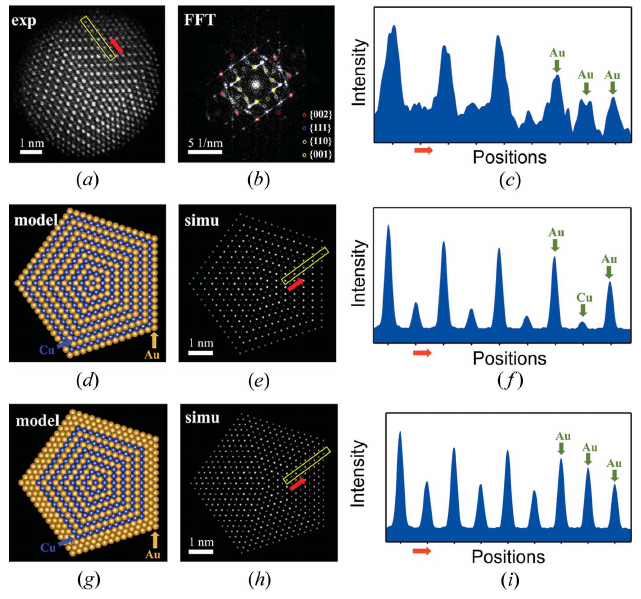
Figure 2 AuCu intermetallic MTPs and surface Au-enriched shell. ( a ) Experi- mental atomic resolution HAADF image of an AuCu MTP and its FFT in ( b ). Four sets of points are marked with different colors separately and some less obvious points are marked with broken circles. ( c ) Intensity profiles across the particles measured along the direction of the red arrow from the yellow box shown in ( a ). ( d ) Theoretical model of AuCu MTP without a surface Au-enriched shell, its simulated HAADF image in ( e ) and corresponding intensity profile in ( f ). ( g ) Theoretical model of AuCu MTP with a surface Au-enriched shell and its simulated HAADFimage in ( h ) and corresponding intensity profile in ( i